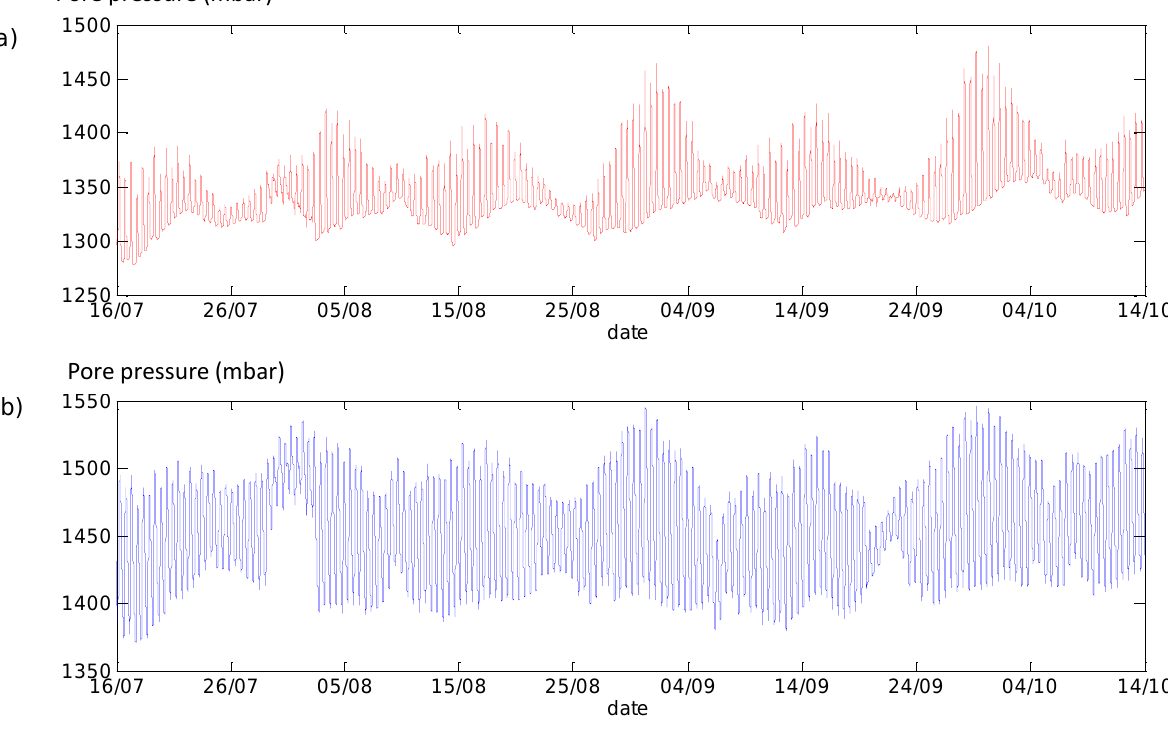
Figure 21. Pore pressure sensor data ( a ) #506, ( b ) #546.